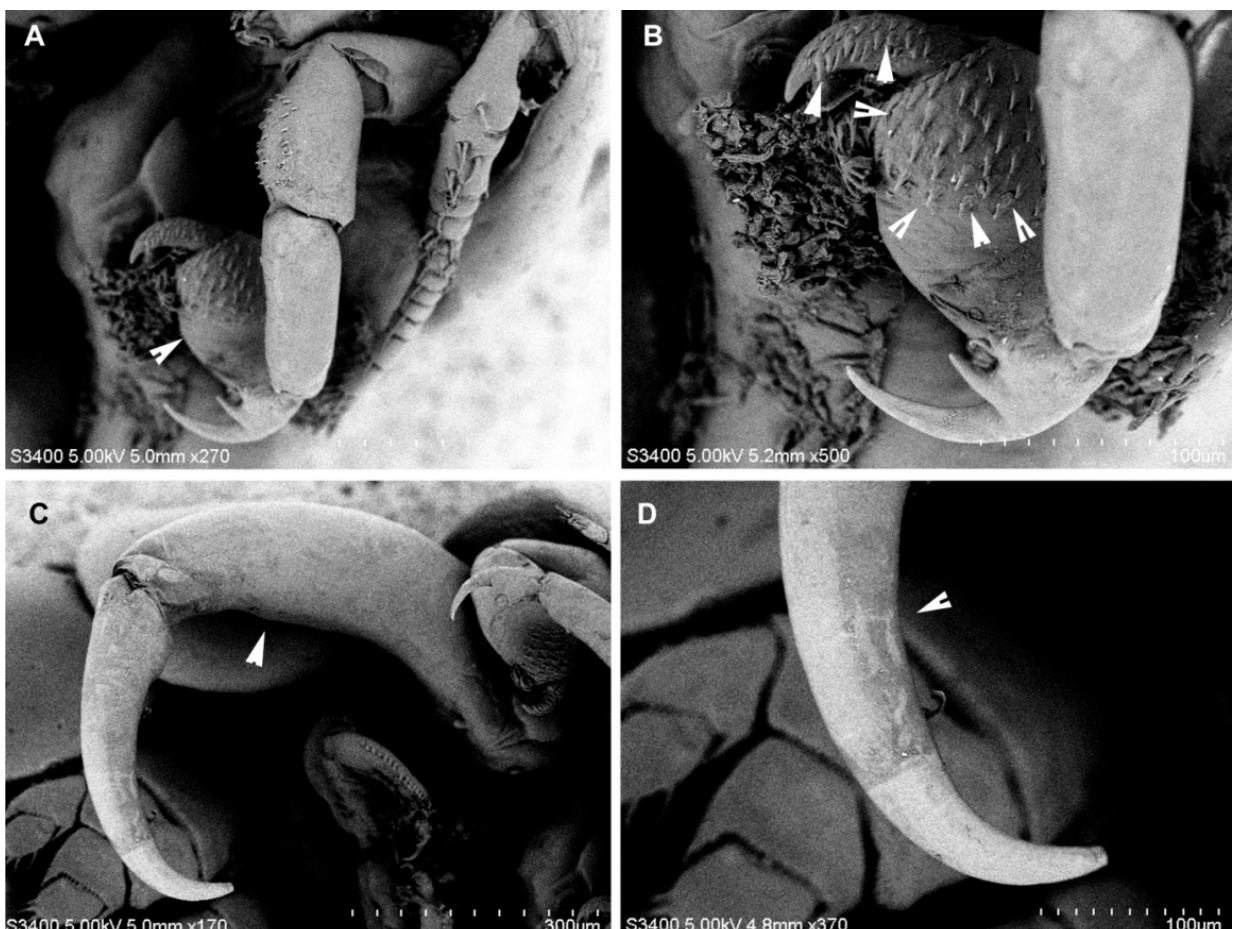
Figure 5. Nemesis santhadevii sp. nov. from Atelomycterus marmoratus , female. ( A ) maxilla (arrow); ( B ) maxilla (arrow showing spinules); ( C ) maxilliped (arrow); and ( D ) maxilliped terminal segment (arrow).